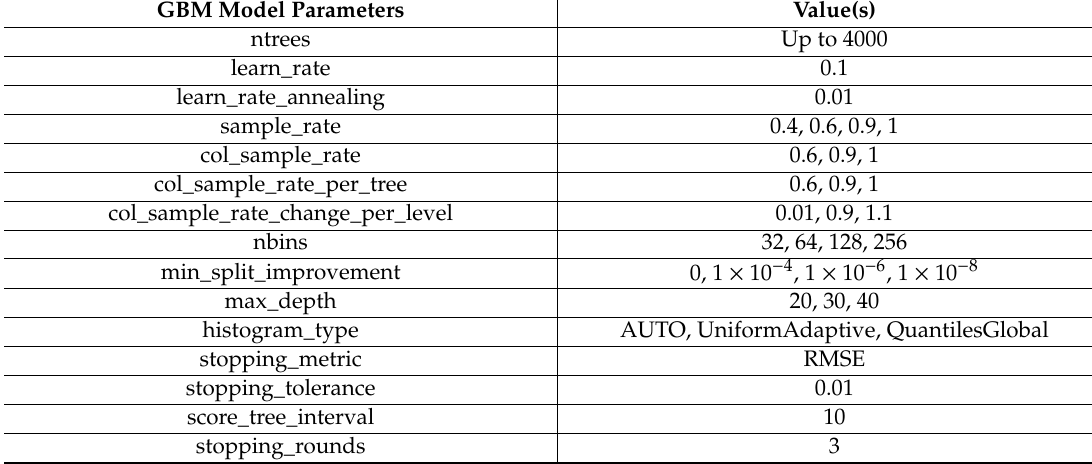
Table 2. Gradient boosting machine (GBM) model parameters. Those with multiple values were those utilized in the hyperparameter tuning